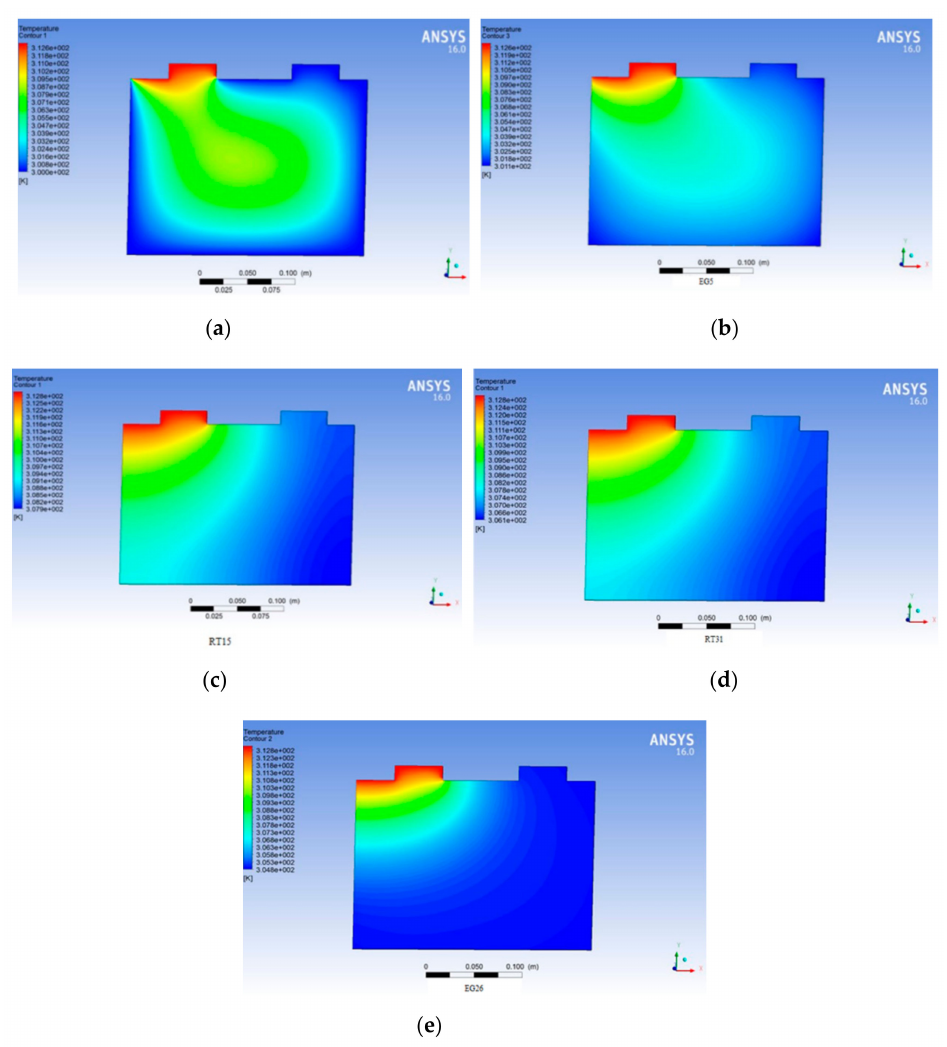
Figure 7. Simulation result temperature contours on a single pouch battery ( a ) without PCM, ( b ) with RT15, ( c ) with RT31, ( d ) with EG5, ( e ) with EG26.